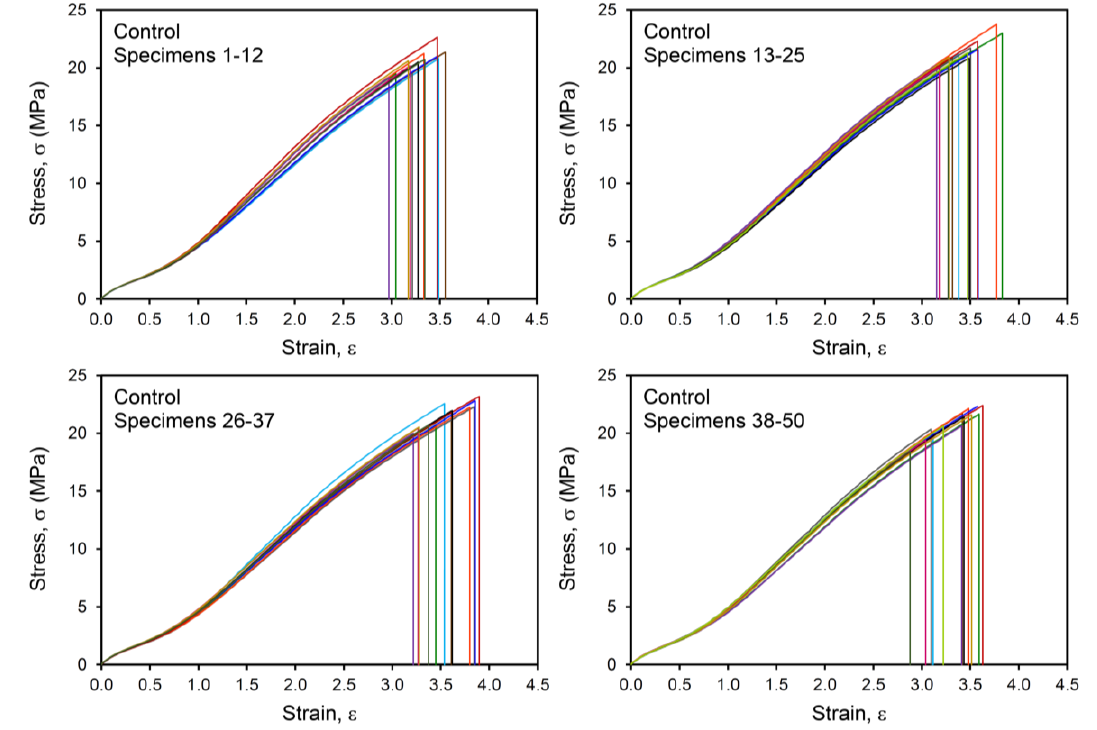
Figure 3. Tensile stress – strain results up to break for Control compound, with data for 50 specimens (replicates) shown using different colored lines.